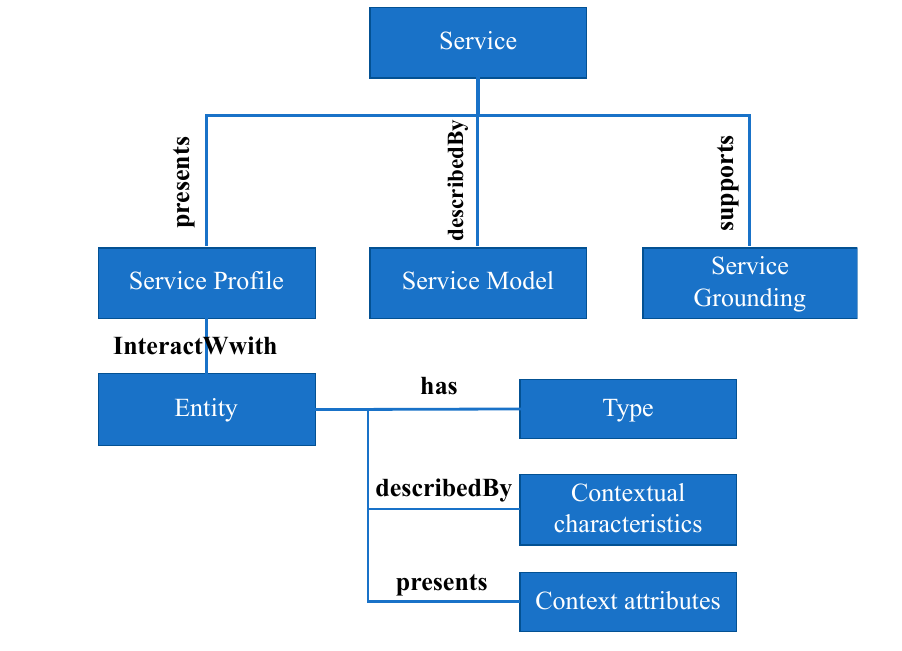
Figure 5. Structure of CSDL.